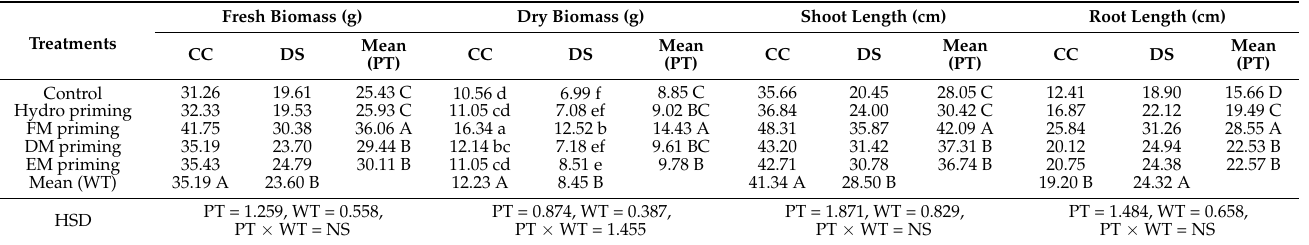
Table 3. Impact of moringa leaf extracts from various landraces as priming agents on growth attributes of rice seedlings cultivated under control and water deficit